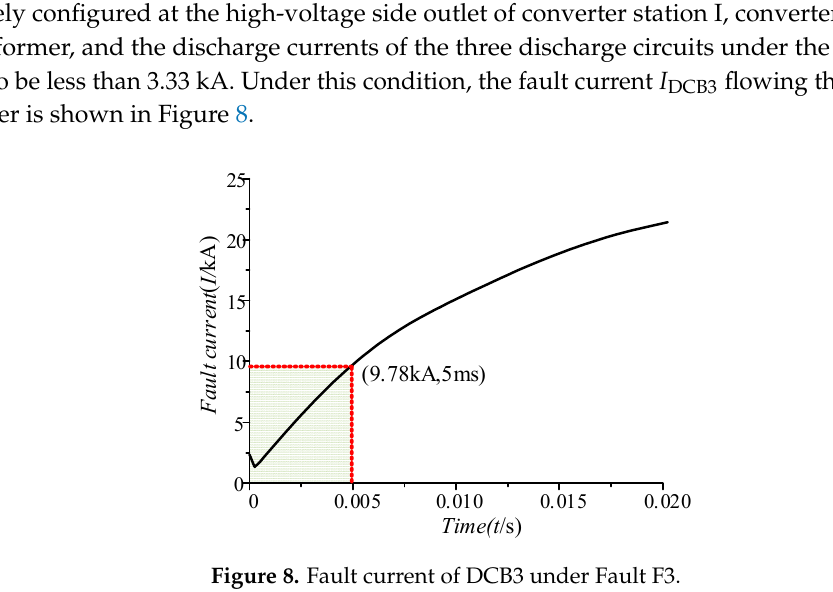
Table 8. Discharge current I 4 under different current limiting reactor of DC transformer. Reactor of Each Pole(mH)